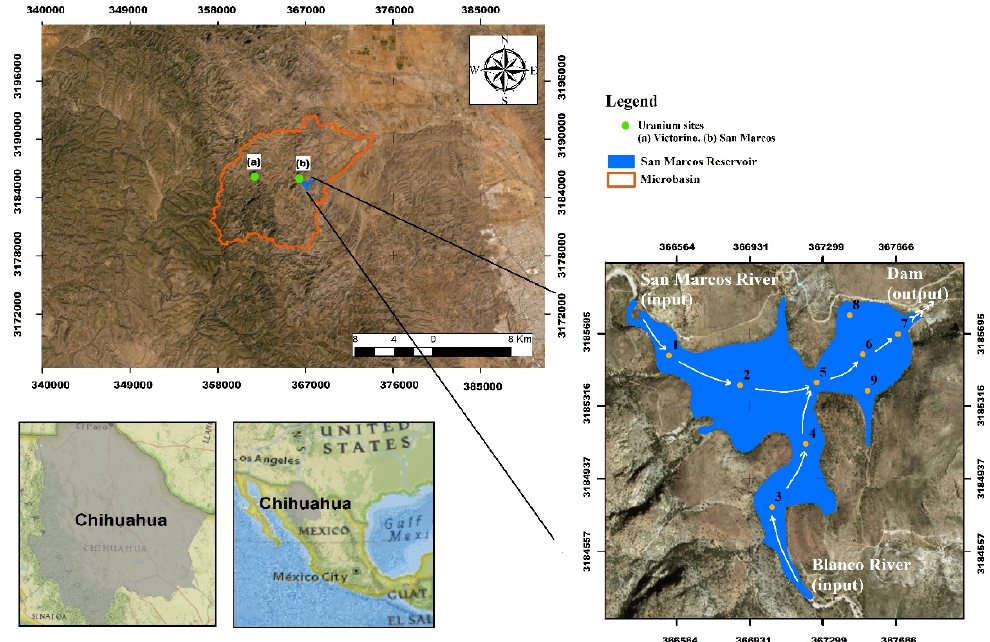
Figure 1. Satellite image of the study area. Distribution of the sampling points, from 1 to 9 along the flux water, in the San Marcos reservoir.